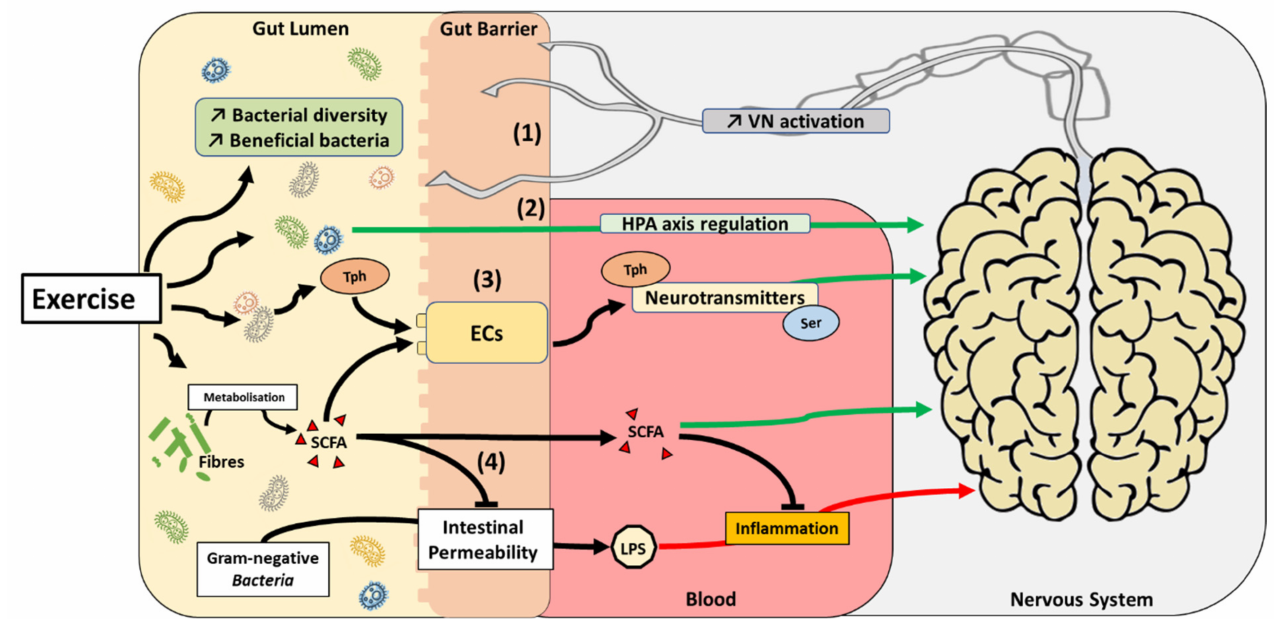
Figure 3. Proposed mechanisms by which exercise can impact the gut microbiota–brain axis. Exercise promotes the development of beneficial bacteria species and increase bacterial diversity in the gut. This phenomenon may have several impacts on the gut microbiota–brain axis: (1) activation of the vagus nerve (VN), (2) activation of the HPA axis, (3) modulation of neurotransmitter metabolism (i.e., tryptophane (Tph) and serotonin (Ser), and/or (4) reduction of inflammation by SCFA